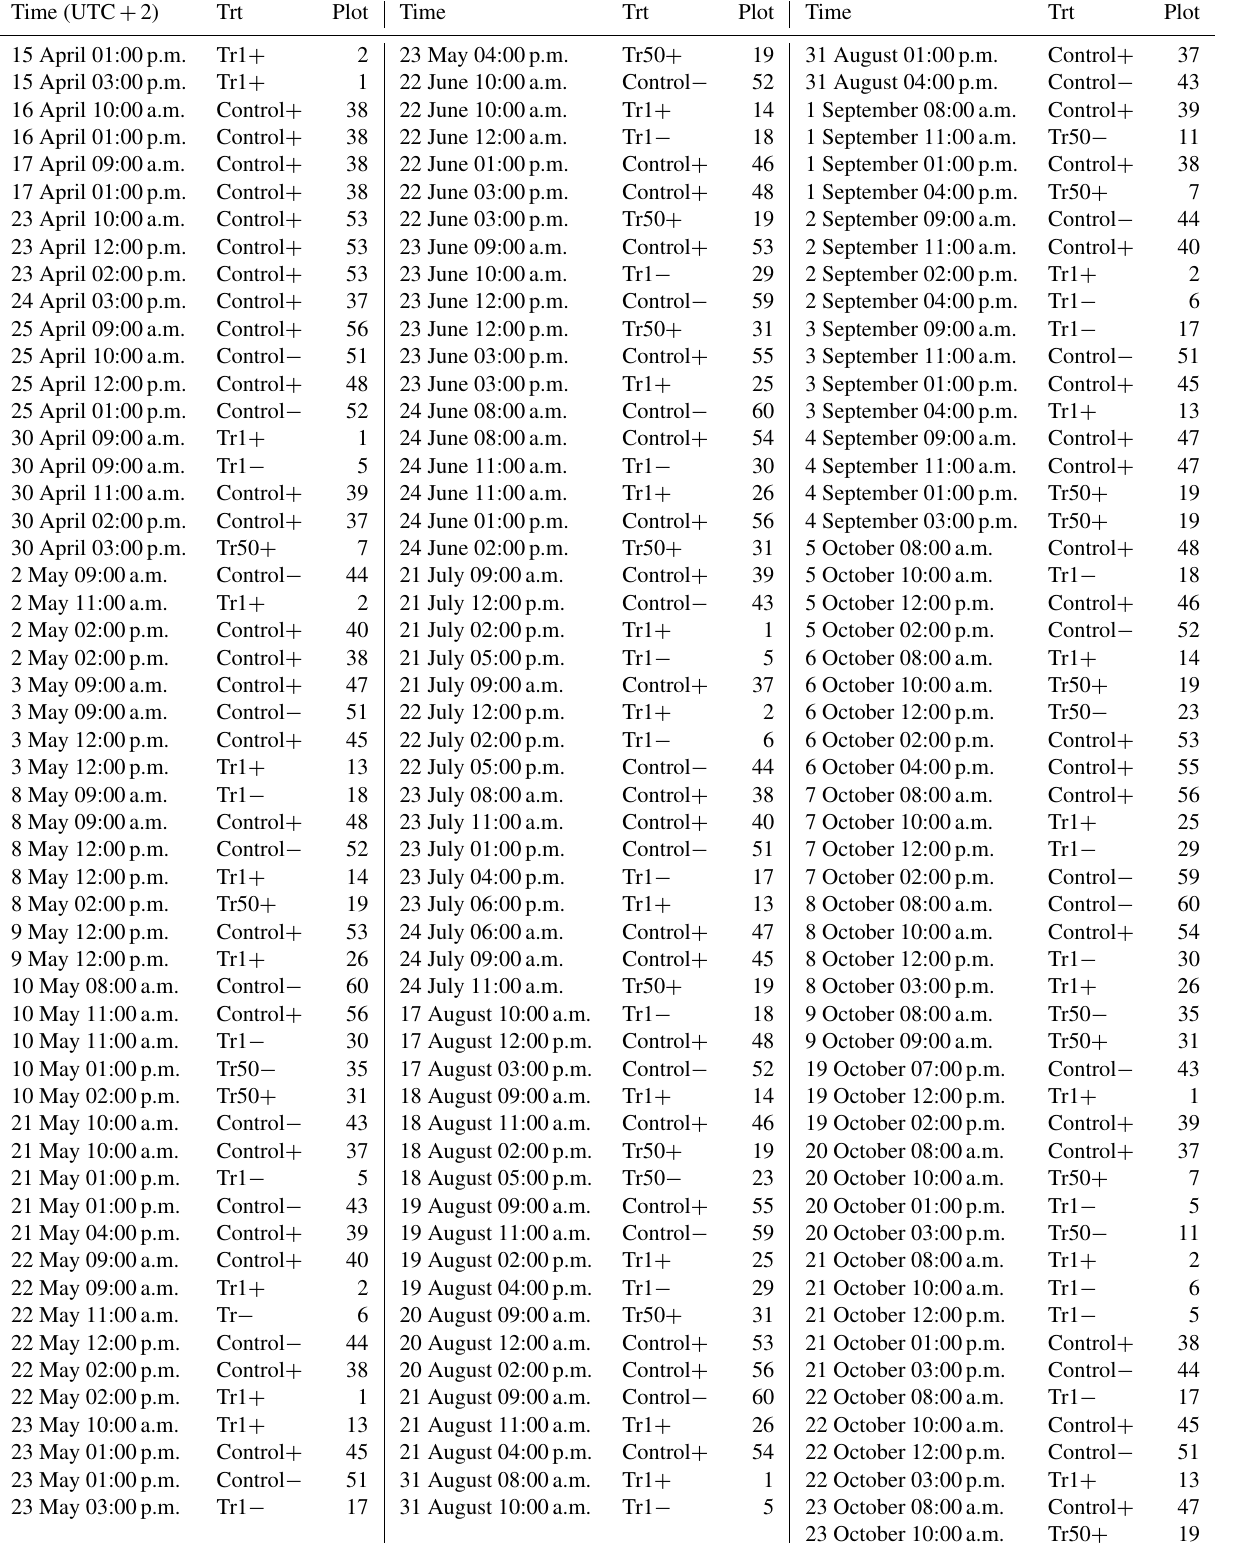
Table A1. Chamber measurements from the different trenching treatments (Control + , Control − , Tr1 + , Tr1 − , Tr50 + , Tr50 − ) from 15 April to 23 October